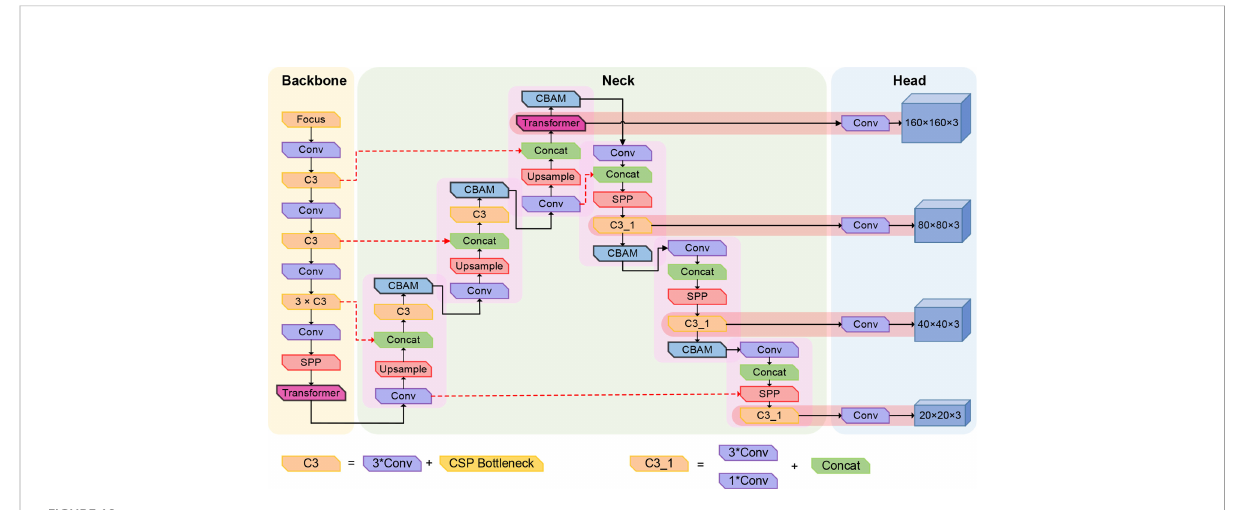
FIGURE 10 Schematic diagram of improved YOLOv5s network